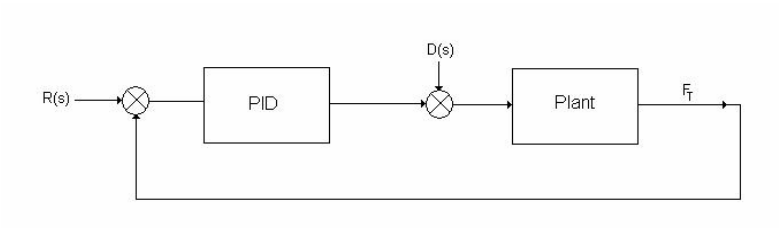
Fig. 13. Block diagram of the Ziegler-Nichols tuned PID